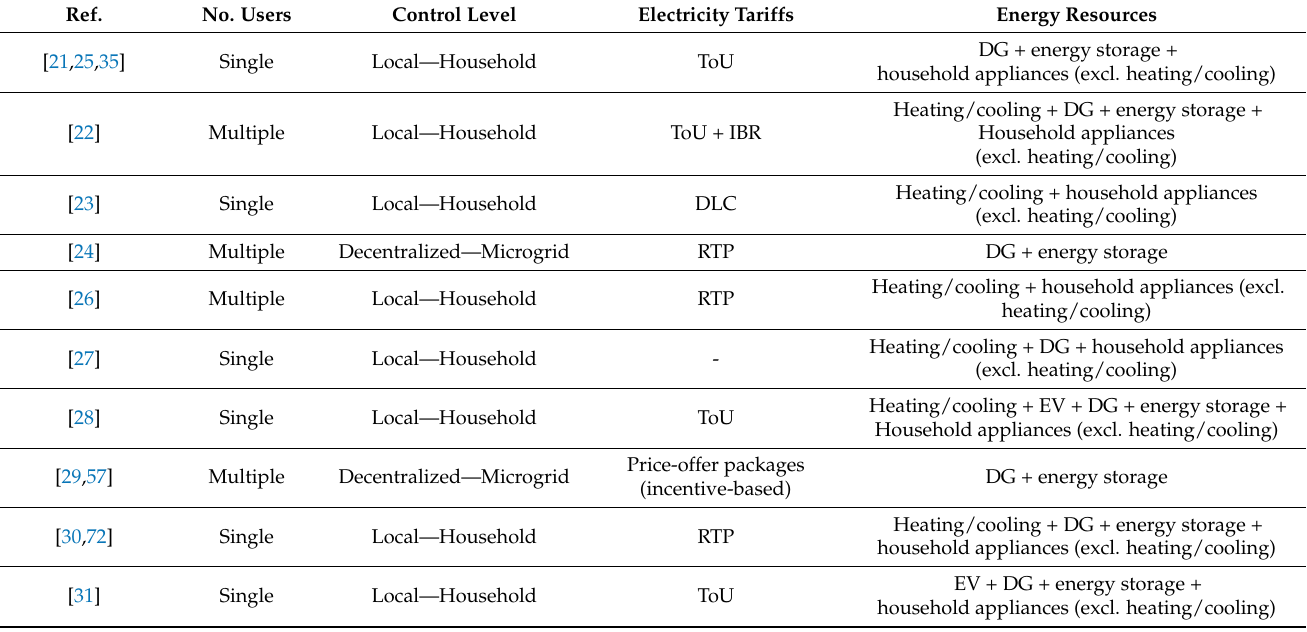
Table 3. Taxonomy of the reviewed works based on the application.